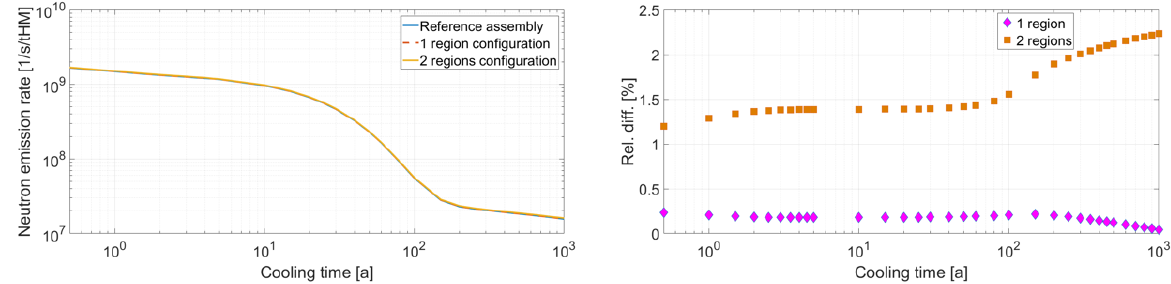
Figure 12. Neutron emission rate as a function of cooling time for different assembly configurations with respect to the reflector.